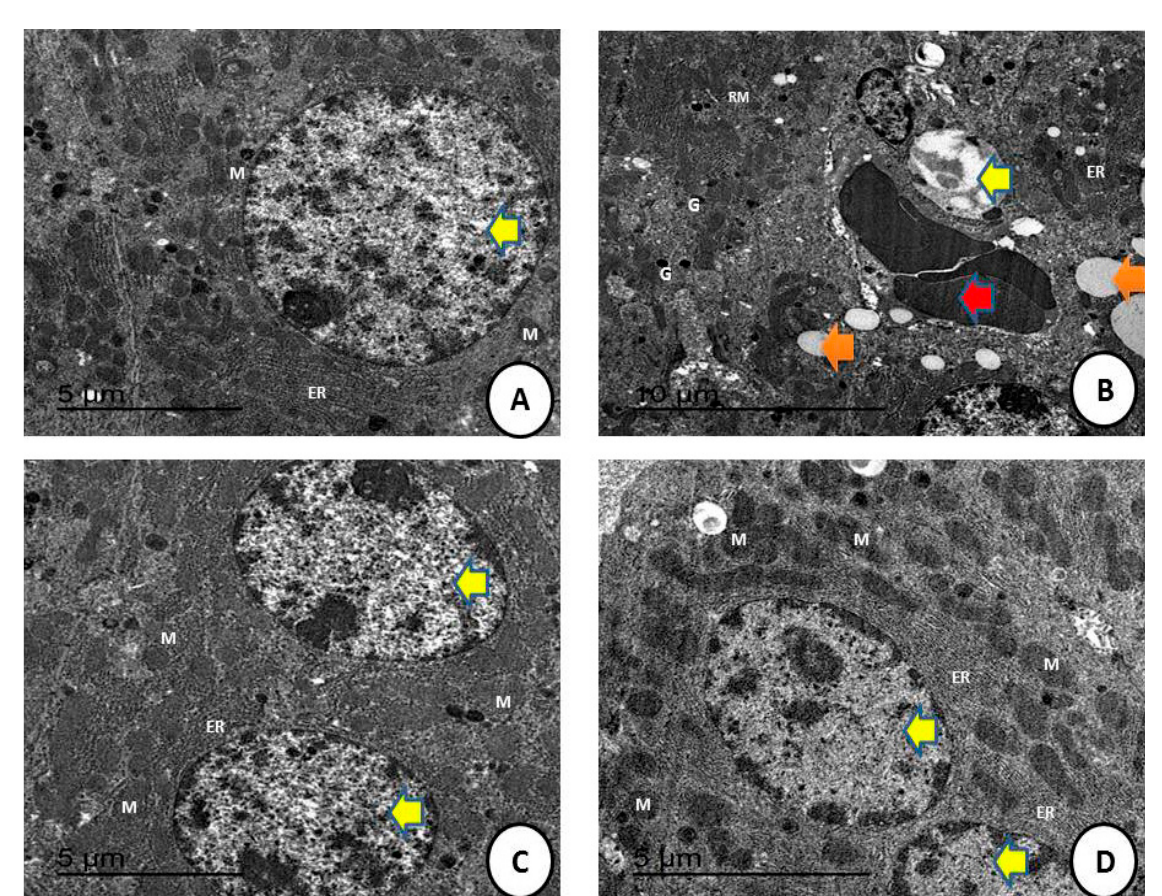
Figure 9. ( A ) An electron micrograph of hepatic tissues of ( A ) the control group showing normal nucleus (yellow arrow) with continuous nuclear membrane and appearance of normal-sized mitochondria (M) and endoplasmic reticulum (ER) (scale bar = 5 µm). ( B ) CdCl 2 -treated group showing detached hepatic parenchyma with large fat droplets as a sort of fatty change (orange arrow) and appearance of blood hemorrhage (red arrow), and necrotic nucleus (yellow arrow) with reduced mitochondria and glycogen granules (G) (scale bar = 10 µm). ( C ) Waste of Taif rose-treated group showing normal nucleus (yellow arrow) with continuous nuclear membrane and appearance of normal-sized mitochondria (M) and endoplasmic reticulum (ER) (scale bar = 5 µm). ( D ) CdCl 2 - and wastes of Taif rose extract-treated group showing restoration of normal-sized nucleus (yellow arrow) with appearance of normal endoplasmic reticulum (ER) and mitochondria (M) with fewer fatty changes (scale bar = 5 µm).